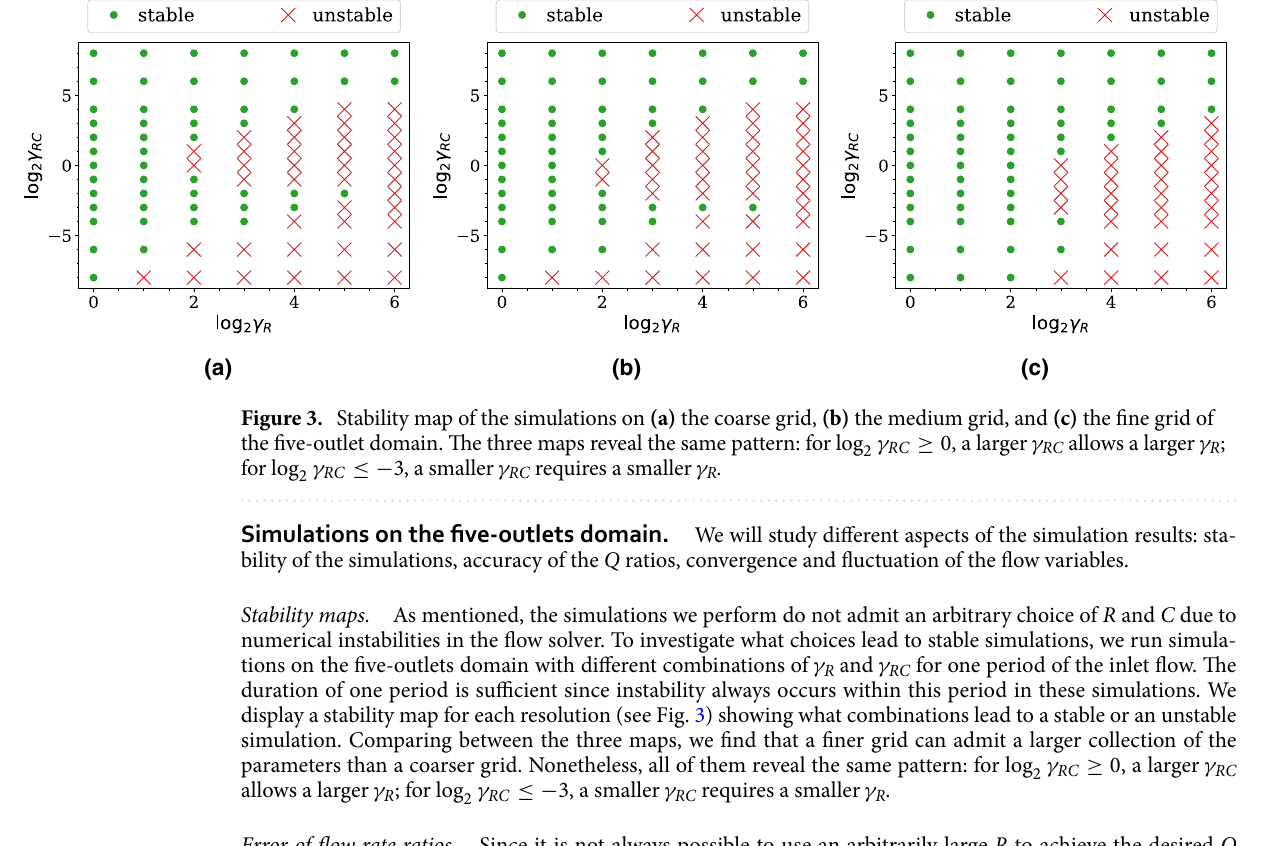
0 , a larger γ RC allows a larger γ R ; ≥